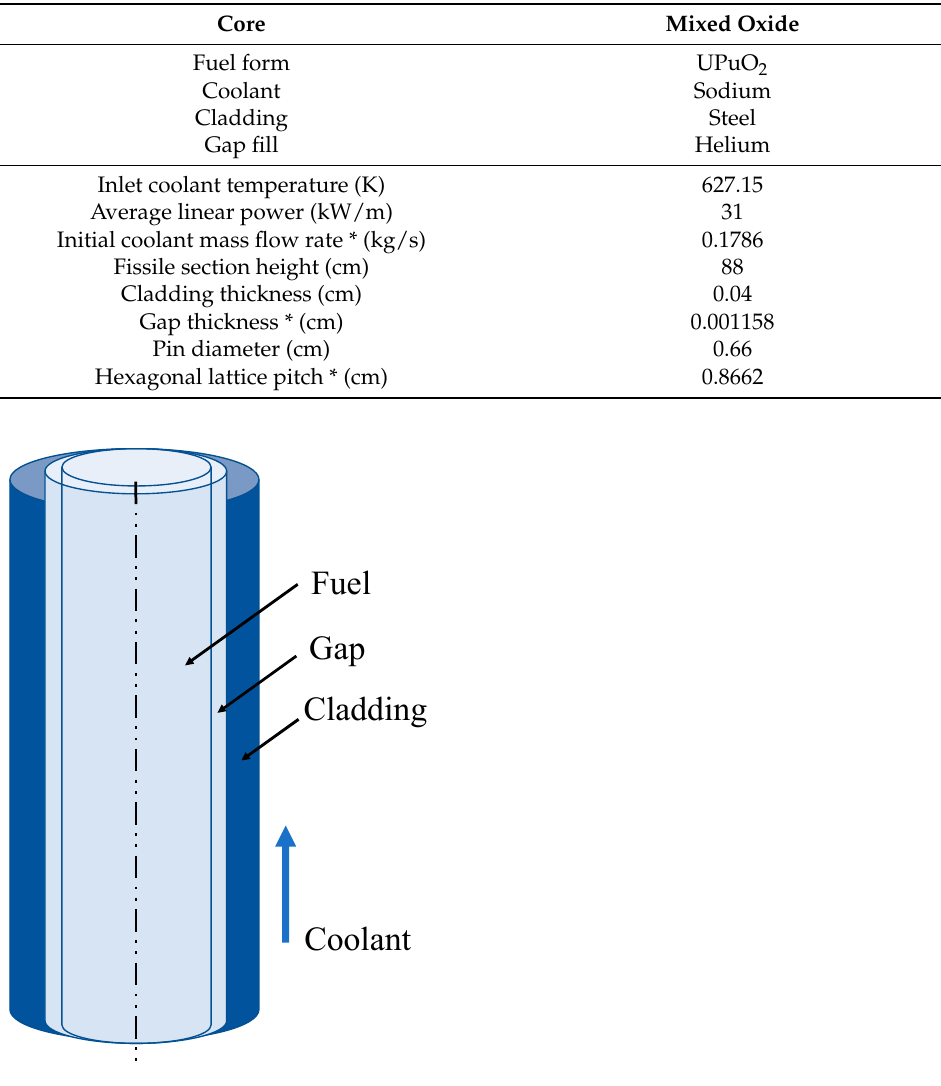
Table 1. Design parameters for the mixed oxide reactor based on a BN-800 reactor [33]. * corre- sponds to calculated values.